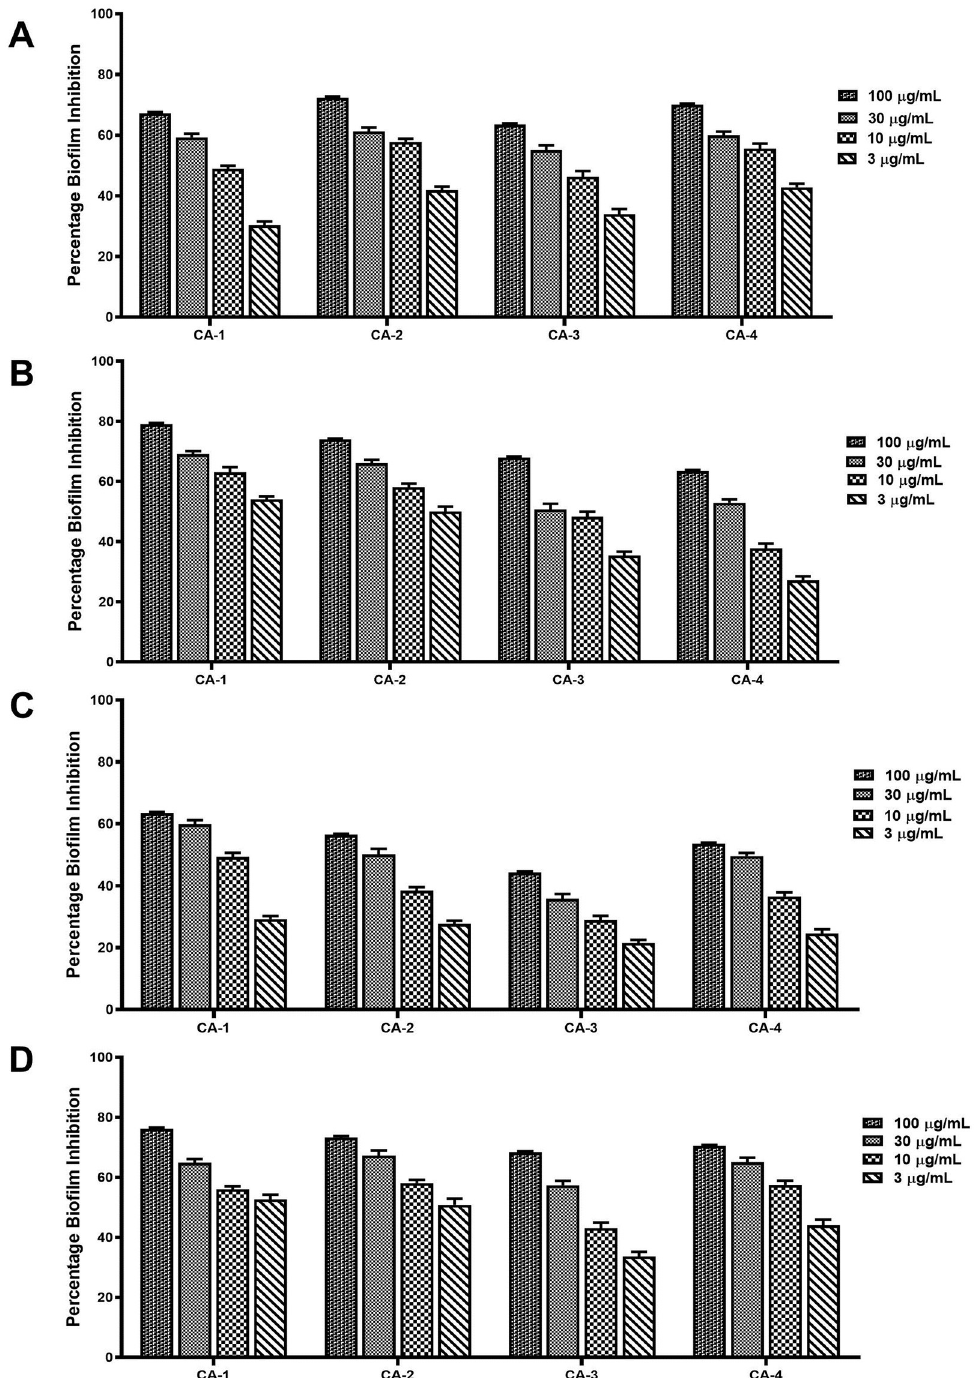
Fig 2. Biofilm formation inhibitory effect of compounds 1–4 (A-D) in the Clinical isolates of C . albicans (CA-1, CA- 2, CA-3 and CA-4).